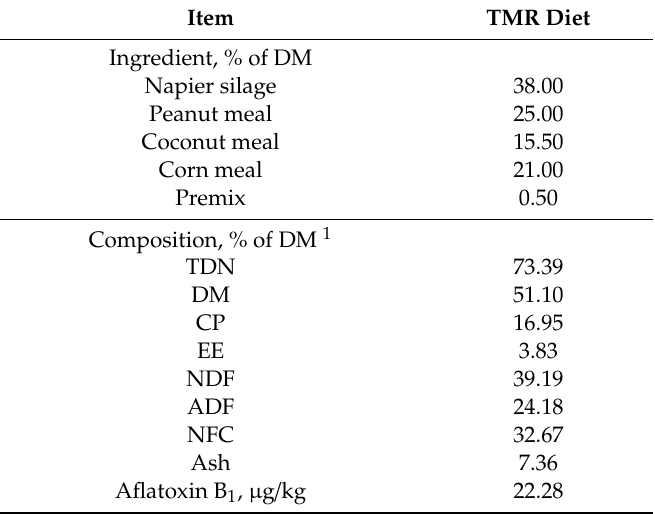
Table 1. Ingredients and chemical composition of experimental diets on a DM